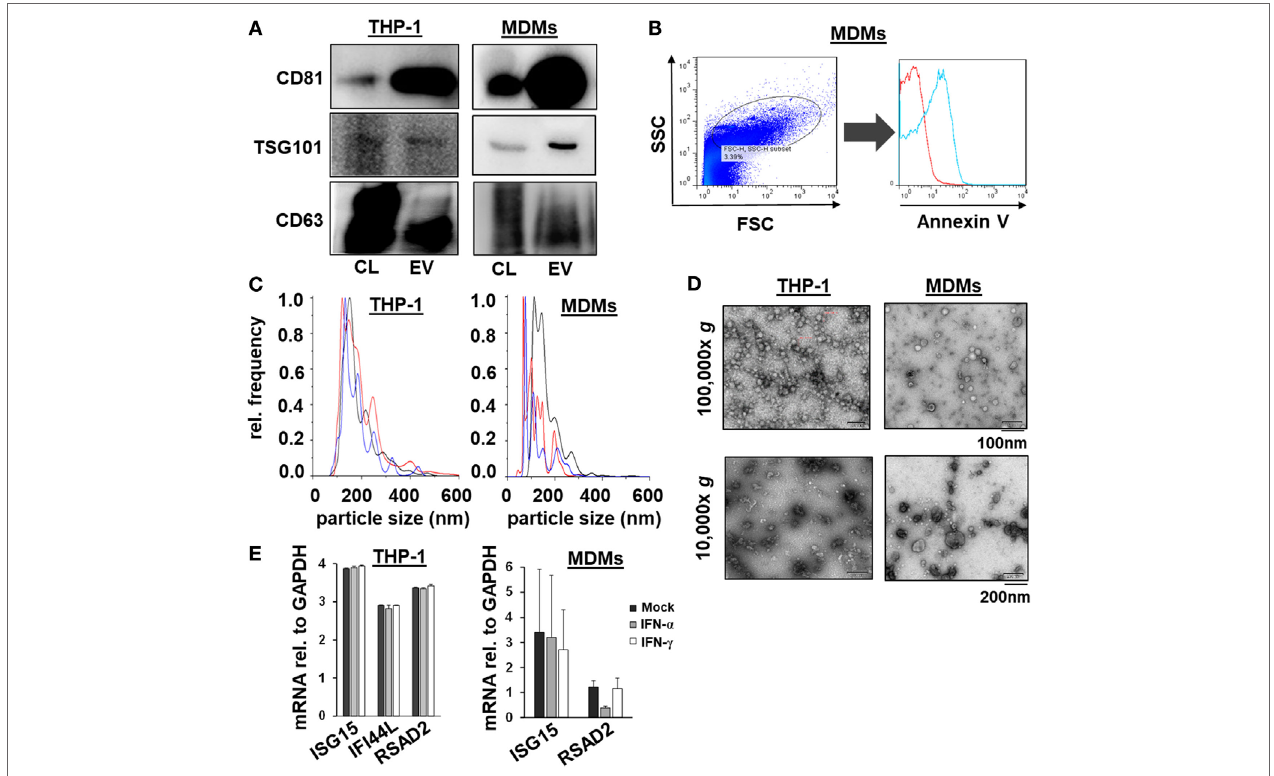
FigUre 4 | Characterization of macrophage-derived extracellular vesicles (EVs) by Western blot, flow cytometry, nanoparticle tracking analysis, electron microscopy, and quantitative PCR. (a) Western blots analysis of CD81, TSG101, and CD63 from EVs and cell lysates (CL) of naïveTHP-1 cells and MDMs (20 µg protein